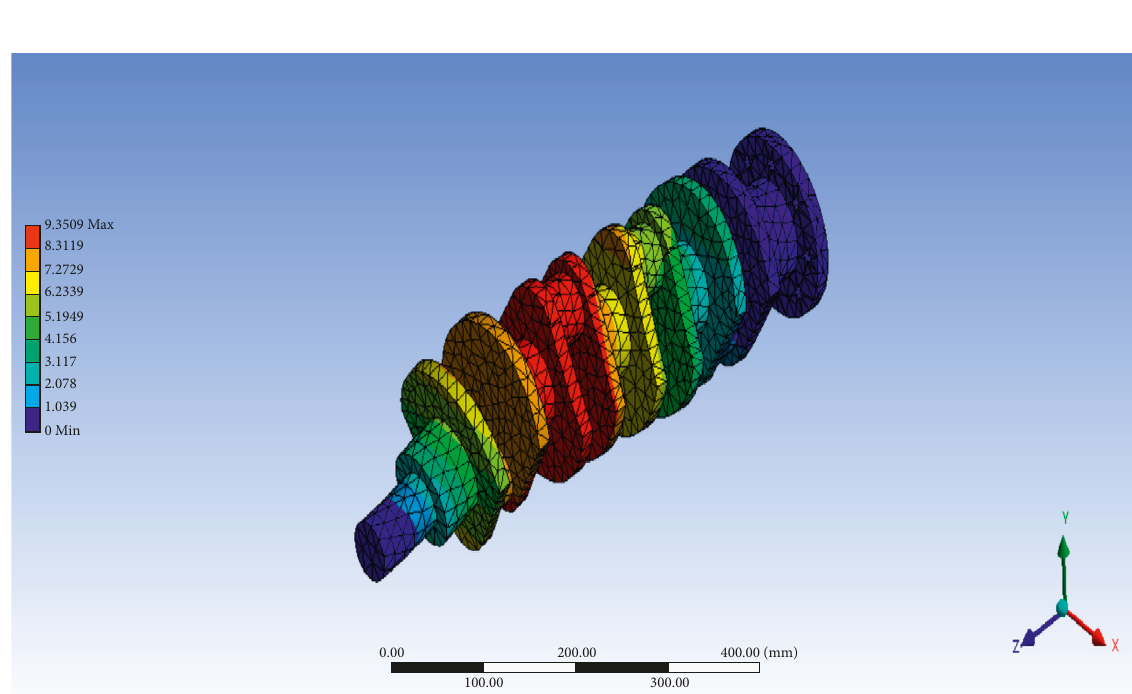
Figure 5: Deformation of stainless-steel crankshaft at the first mode of